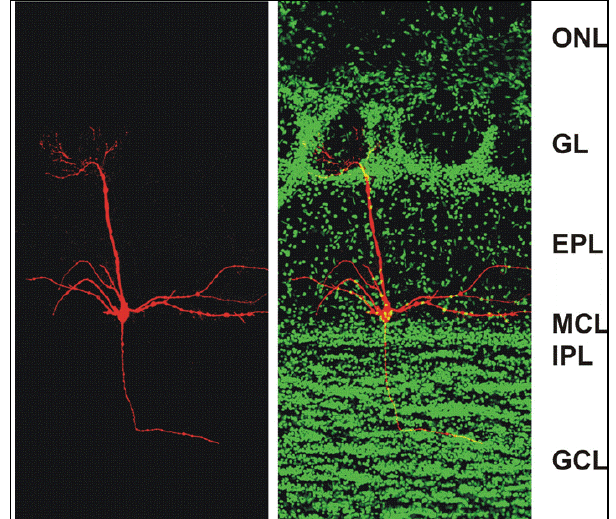
Figure 1. Confocal micrographs of a section of the adult mouse main olfactory bulb with a single mitral cell intracellularly filled with biocytin ( red ) and nuclei stained with Sytox Green ( green ). The mitral cell soma is located in the mitral cell layer (MCL). One apical dendrite of the mitral cell reaches into one glomerulus and several lateral dendrites span the main olfactory bulb. ONL: olfactory nerve layer; GL: glomerular layer; EPL: external plexiform layer; MCL: mitral cell layer; IPL: internal plexiform layer; GCL: granule cell layer. From